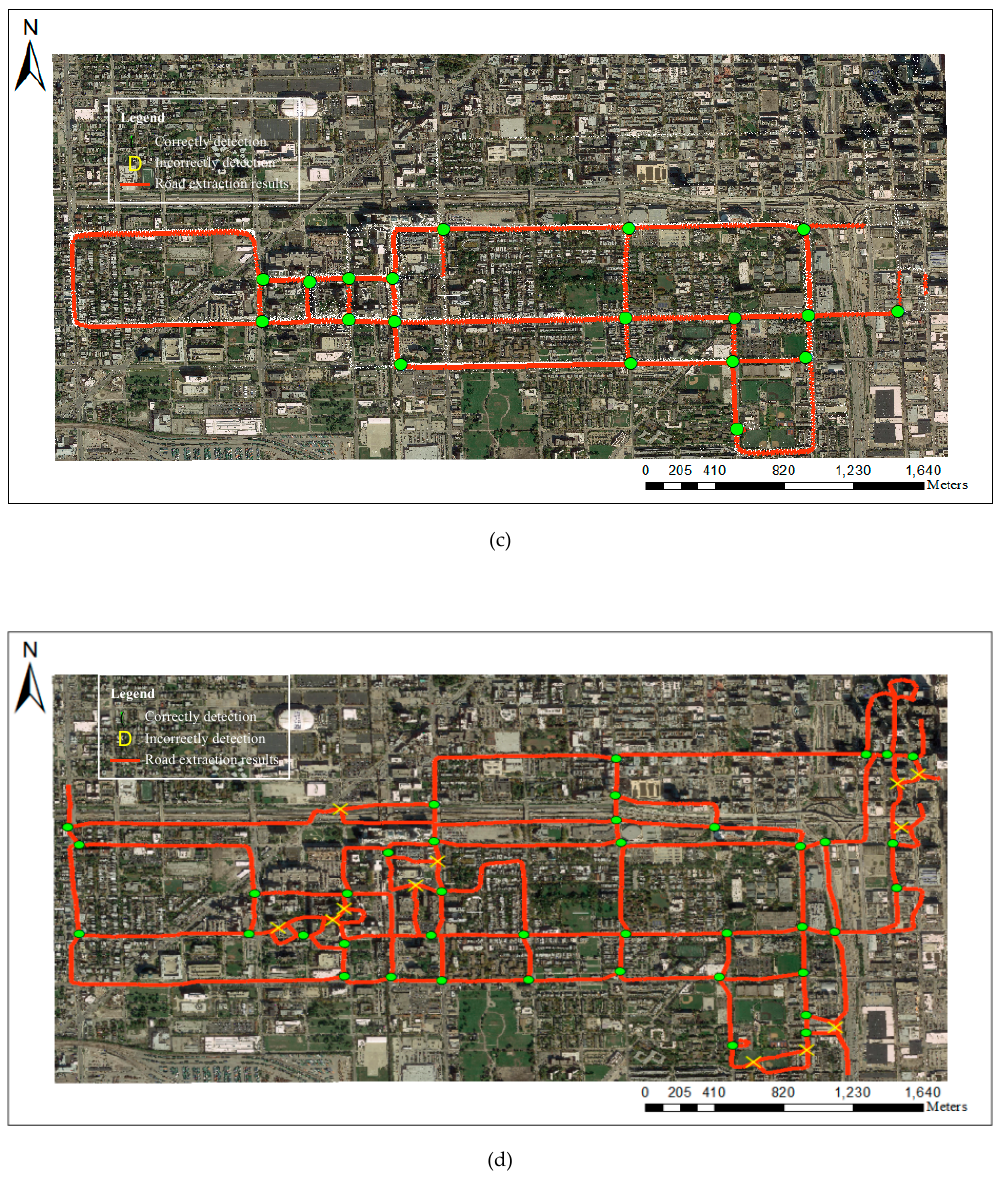
Figure 19. The detection results using Davies’ method and Ahmed’s method: ( a ) Davies’ detection results in Wuhan; ( b ) Ahmed’s detection results in Wuhan; ( c ) Davies’ detection results in Chicago; ( d ) Ahmed’s detection results in Chicago.